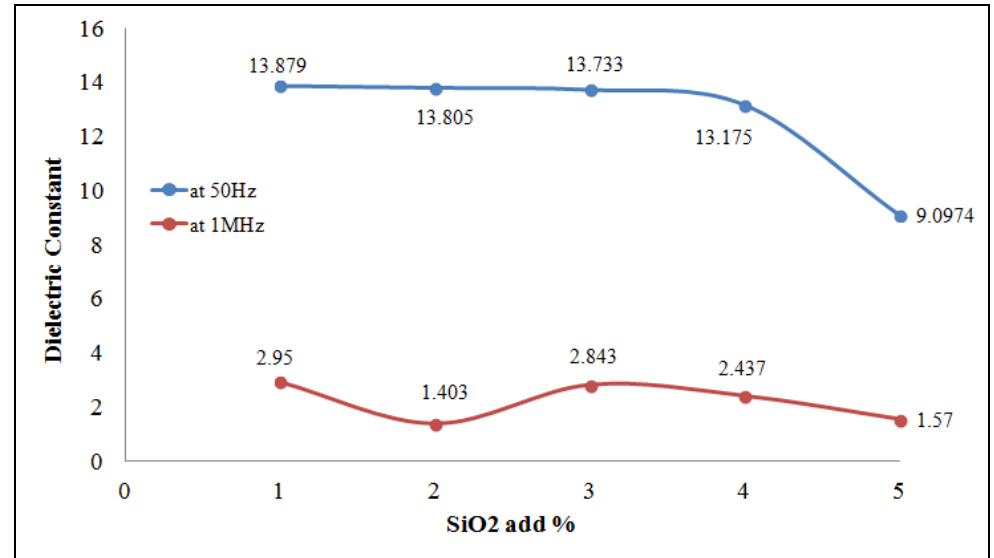
Fig.8: Dielectric constant (K) for UP/ nano SiO with filler) at 50Hz and 1MHz.